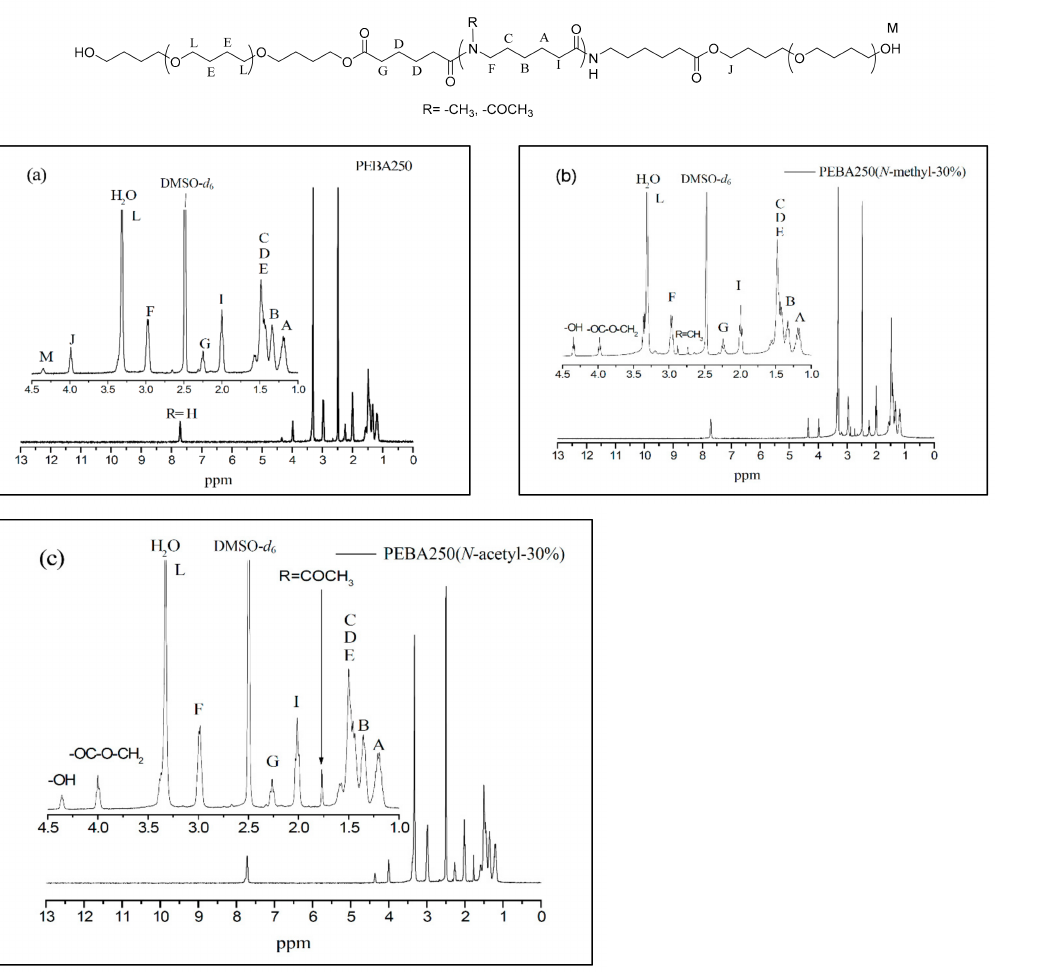
Figure 5. 1 H NMR spectra of ( a ) Polyether- block -amide (PEBA 250), ( b ) PEBA 250( N -methyl-30%), and ( c ) PEBA 250( N -acetyl-30%). A similar phenomenon could also be observed in the PEBA 250 series; in PEBA 250 (Entry 9), PEBA 250( N -methyl-X%) (Entries 13–15), and PEBA 250( N -acetyl-X%) (Entries 19–21), the crystallinity of N -methyl fell from 74.3% (Entry 9) to 71.8%, 48.3% and 35.4% (Entries 13–15) as the substituent ratio was increased, whereas in N -acetyl cases, the crystallinity of PEBA 250( N -acetyl-10%, -20%, and -30%) fell from 74.3% (Entry 9) to 54.2%, 57.0% (Entries 19,20) and then rebounded to 79.7% (Entry